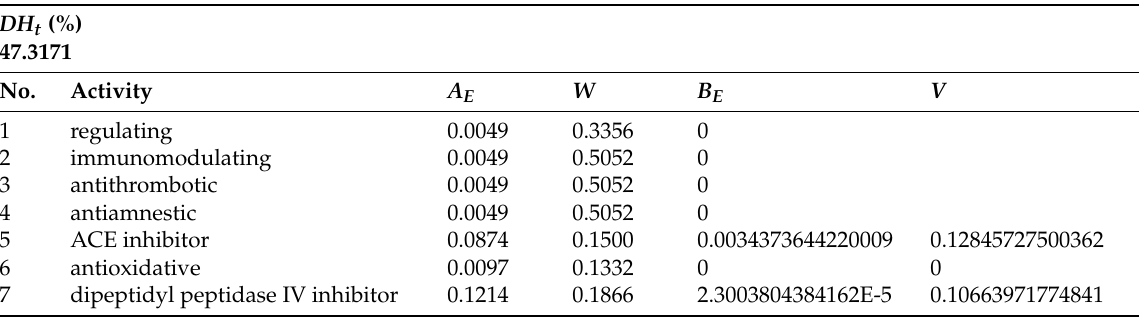
Table A42. A E , DH t , W , B E and V values from RubisCO of Halophila stipulacea . In silico enzymatic cleavage was carried out by using calpain 2.